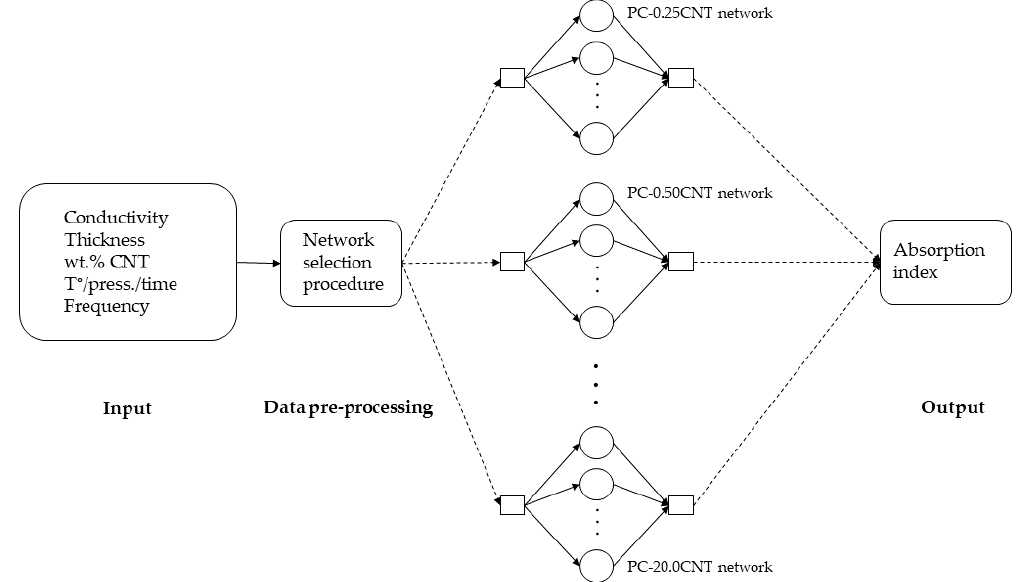
Figure 2. Synoptic diagram describing the steps of the proposed system.